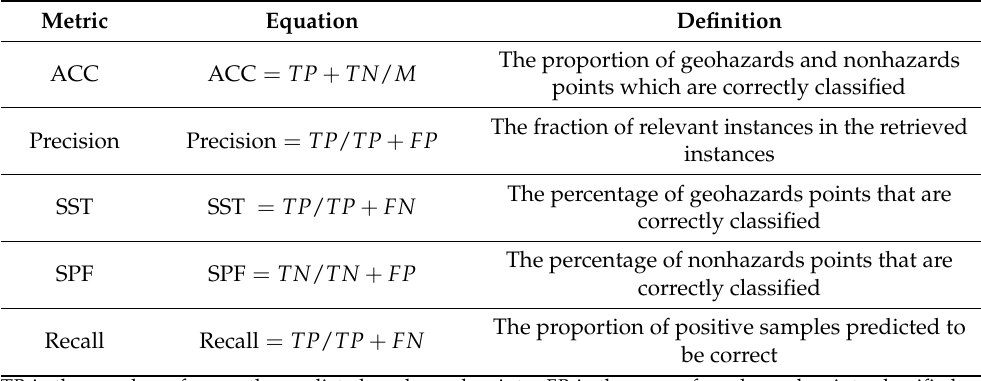
Table 3. Formula and definition of evaluation